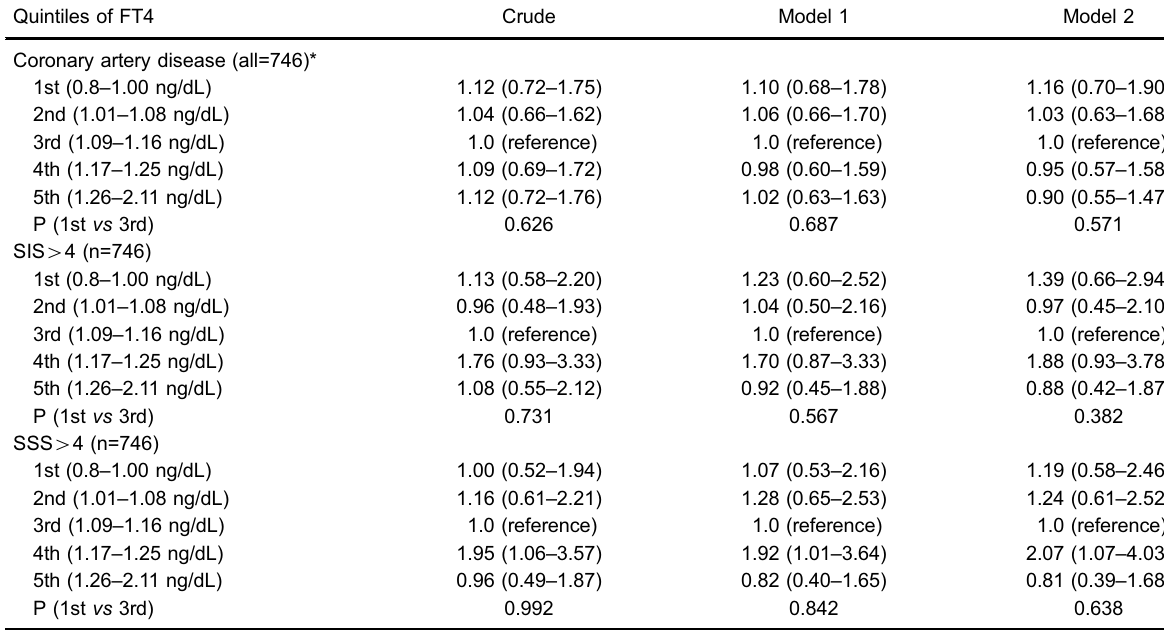
Table 5. Odds ratio and 95% con fi dence interval of association of coronary artery disease and quintiles of free thyroxine (FT4). Quintiles of